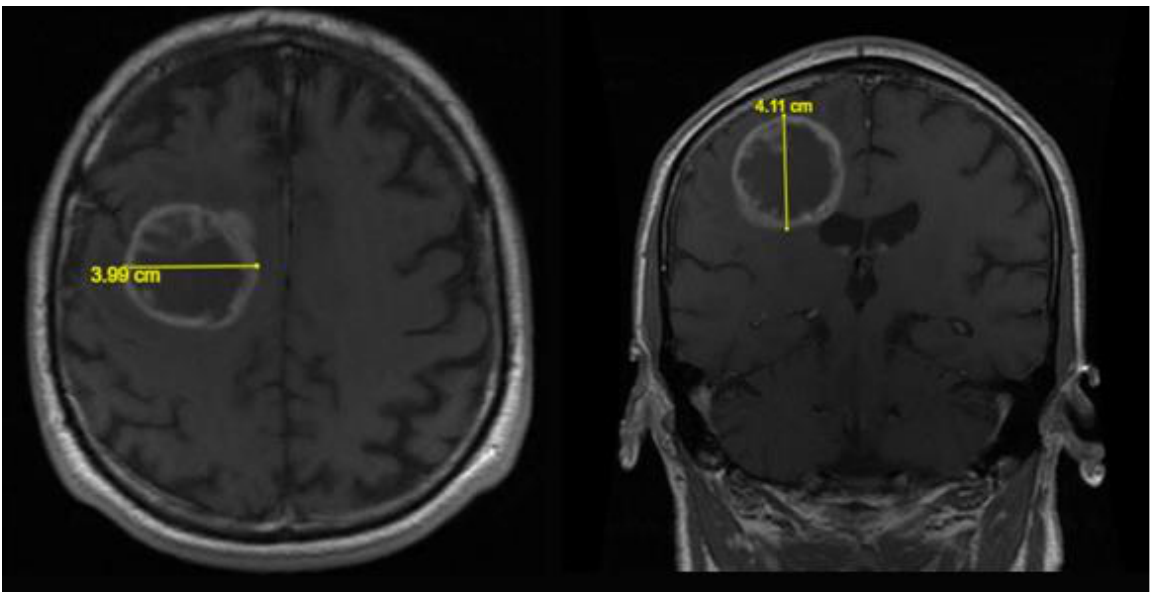
Figure 1. Axial and coronal T1 weighted MR images with measurement of the latero-lateral and cranio-caudal diameters of the tumoral lesion.